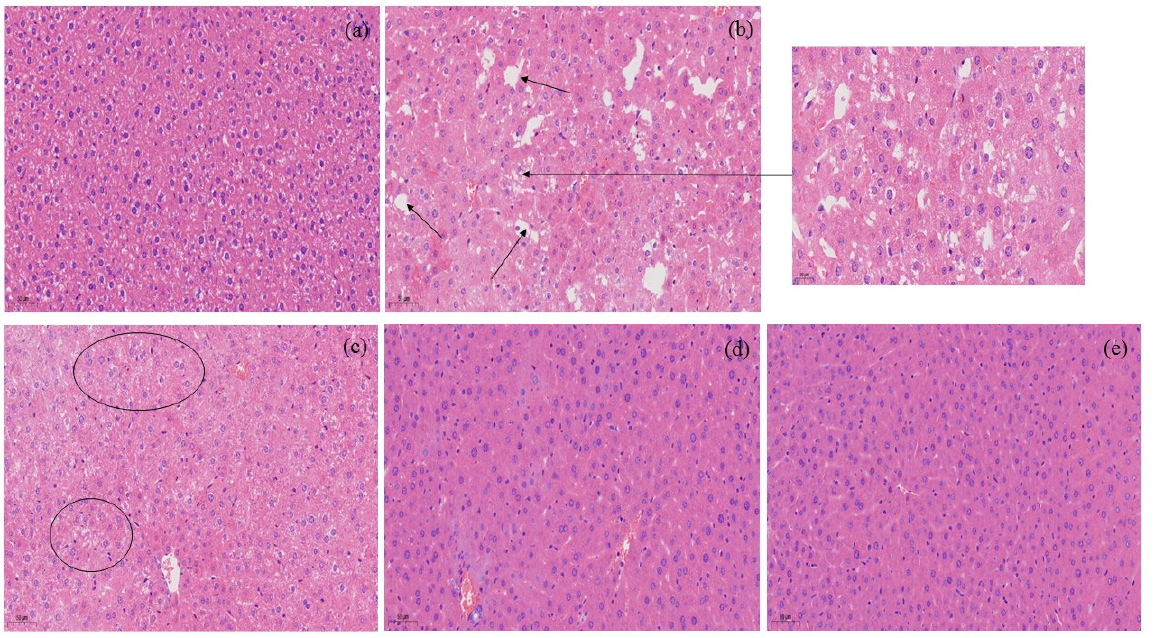
Figure 6. Liver histological images of mice. ( a ) NC group; ( b ) HFD group; ( c ) LIOP group; ( d ) MIOP group; ( e ) HIOP group. The lesion area is marked with arrows and enlarged.